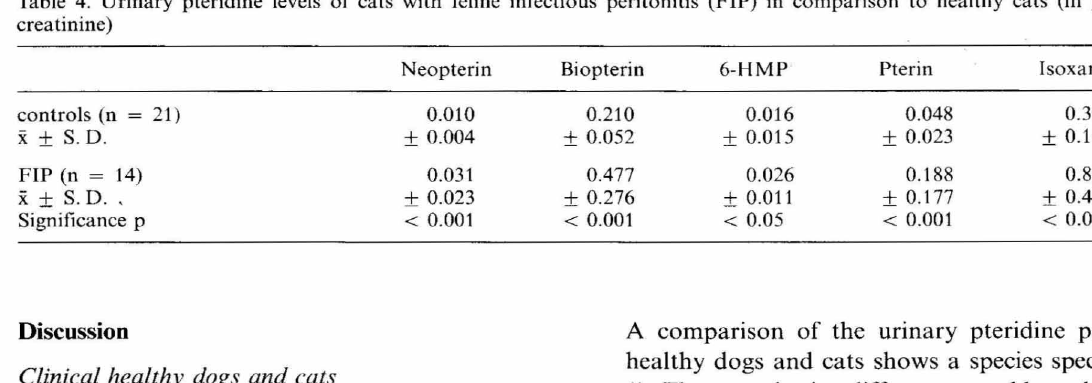
Table 4. Urinary pteridine levels of cats with feline infectious peritonitis (FIP) in comparison to healthy cats (in Ilmol/mmol creatinine)